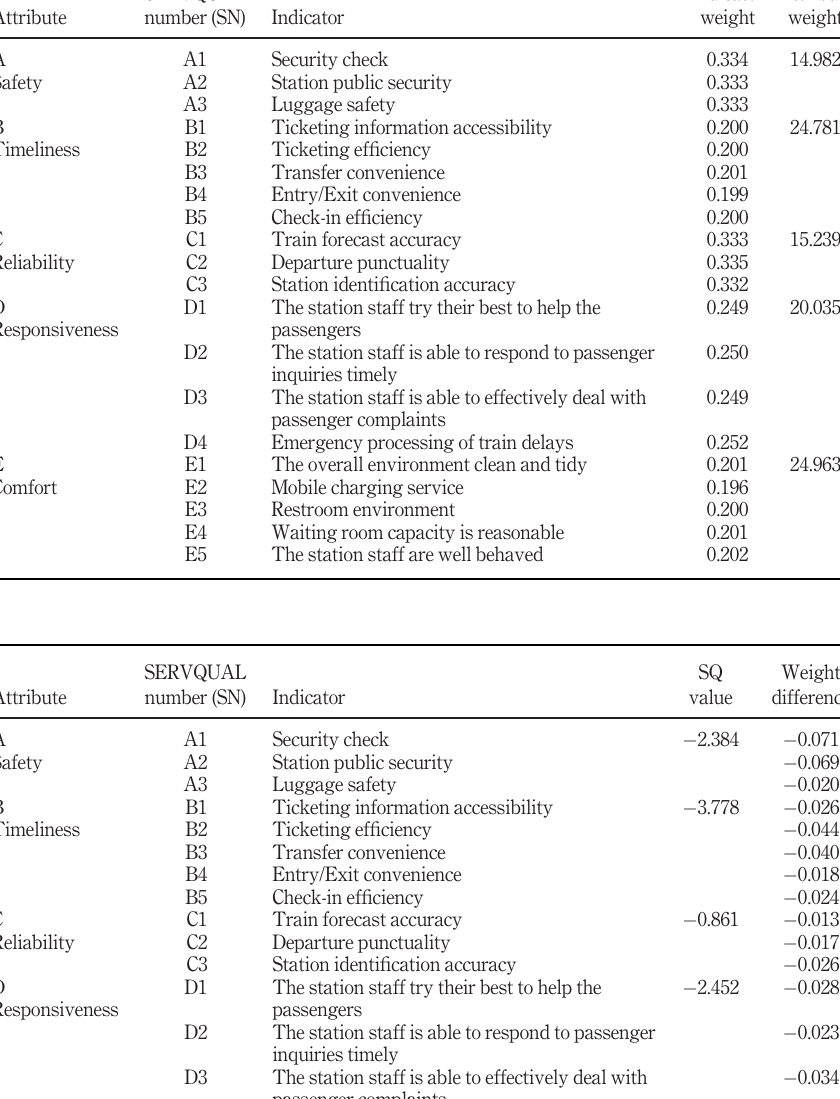
Table 4. SQ value of each attribute and the weight difference of each indicator